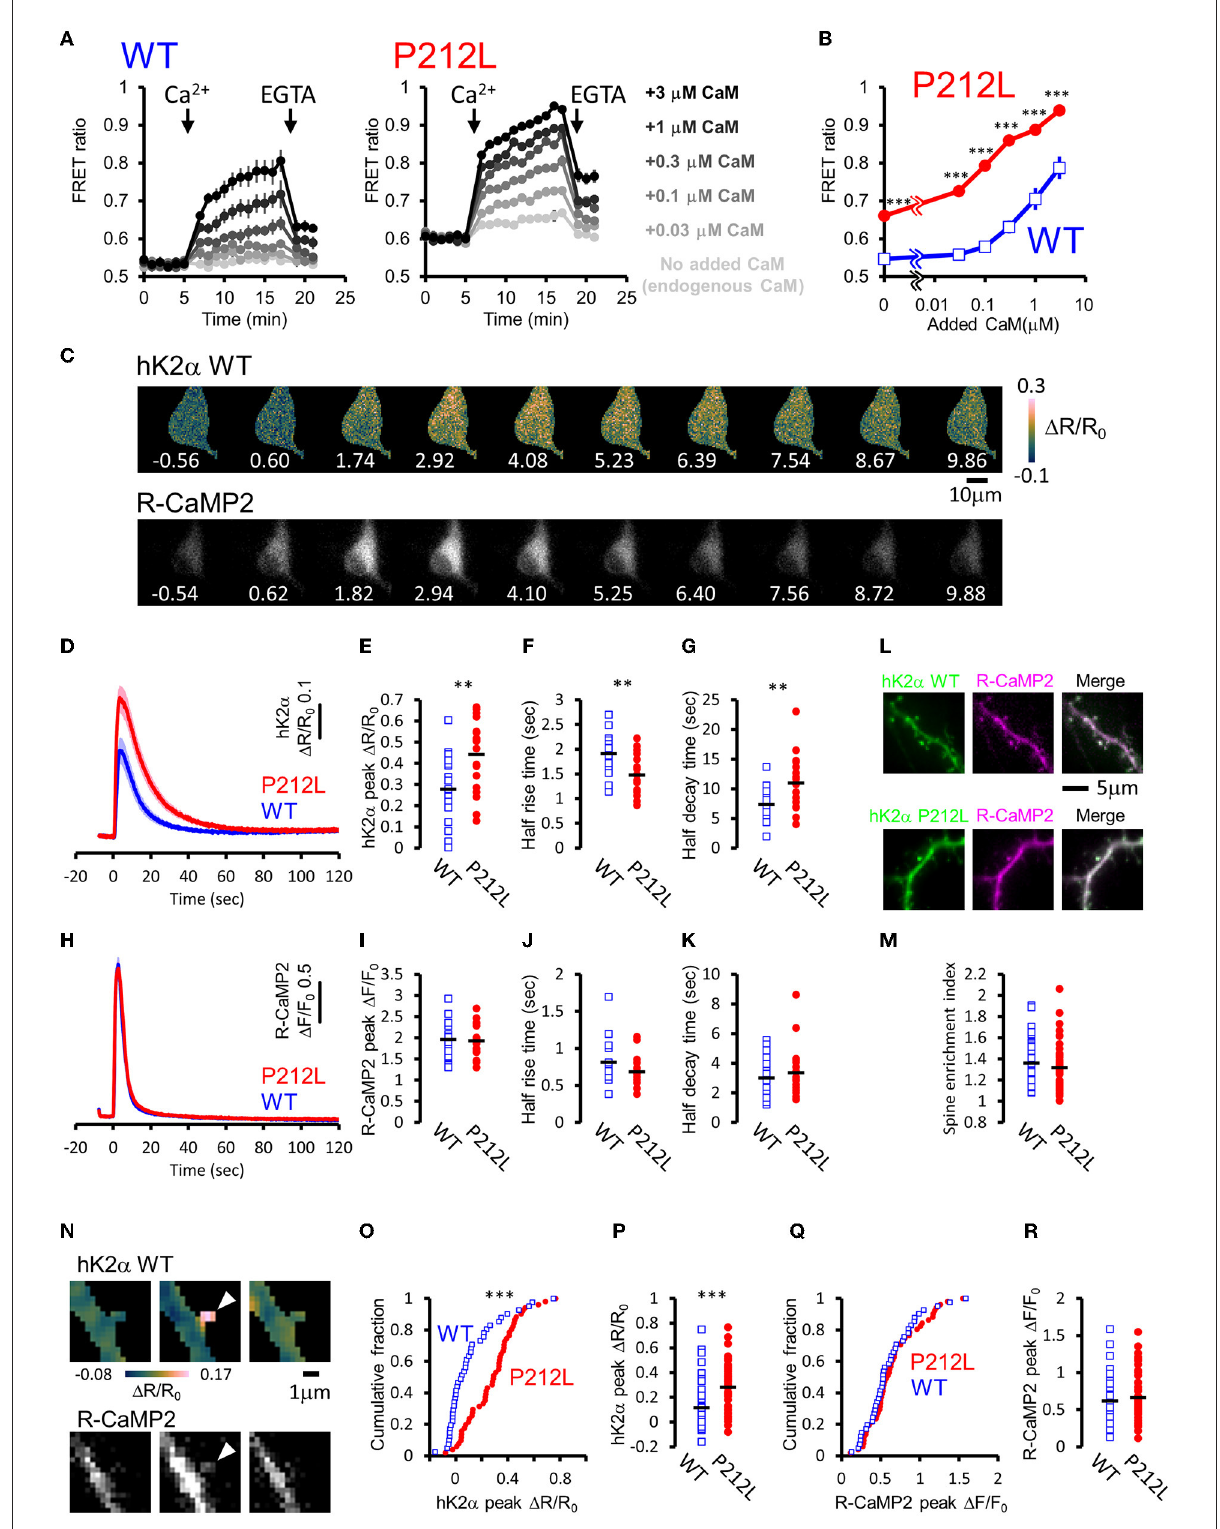
FIGURE3 P212L mutation facilitated Ca 2 + /CaM-dependent activation of CaMKII α , accelerates activation and decelerates inactivation processes. (A) Plate reader FRET measurement of WT (left) and P212L (right) mutant of hK2 α under various concentrations of added CaM. Ca 2 + and EGTA are